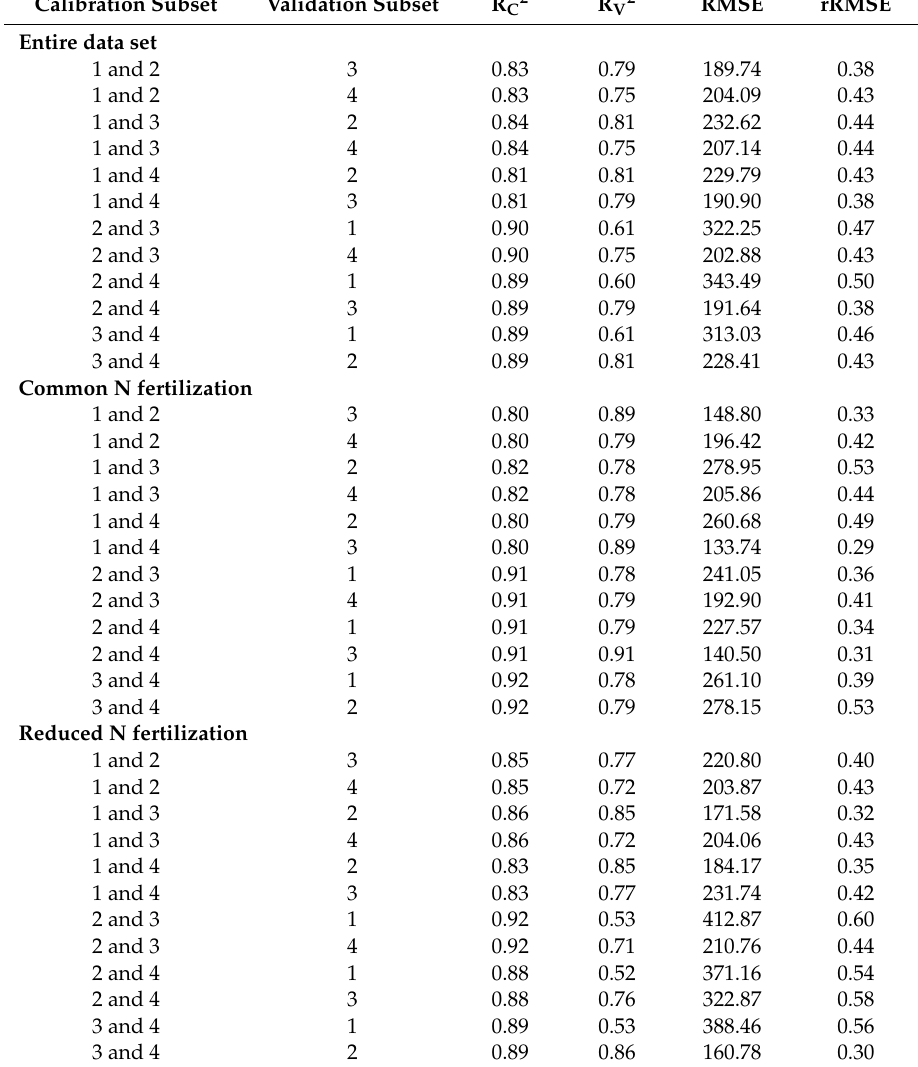
Table A1. Statistics for each run of the biomass regression models (Calibration: R C2 : coe ffi cient of determination; Validation: R v2 : coe ffi cient of determination, RMSE: root mean square error (g / m 2 ), rRMSE: relative root mean square